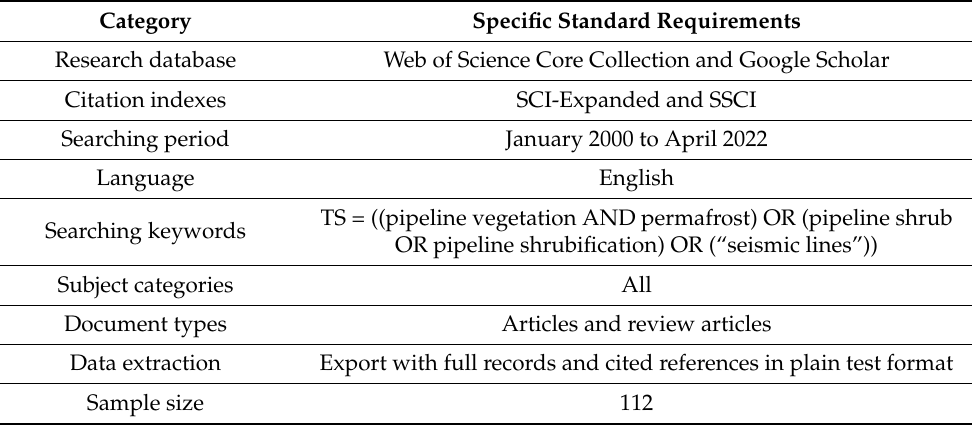
Table 1. Summary of data sources and selection methods in this